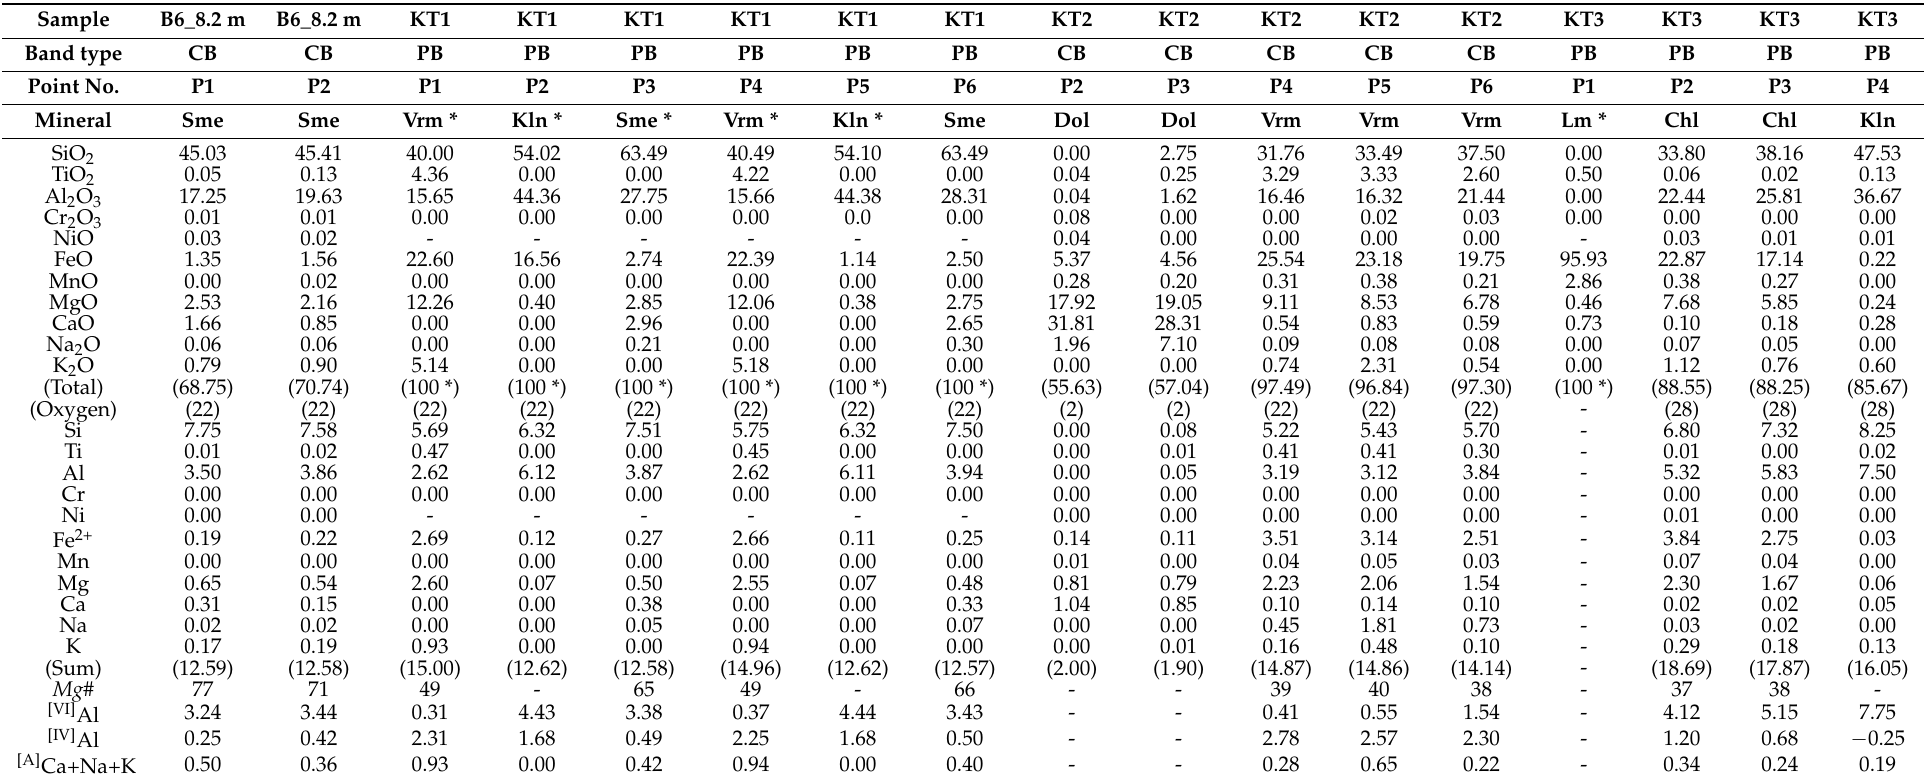
Table 3. Chemical compositions of analyzed minerals (wt.%) with EPMA or SEM-EDS. SEM-EDS analyses are indicated by * marks at the right of both mineral name and total, which are normalized to 100 wt.% in total. For EPMA analyses without * marks, the total is the total weight percent of measured oxide, which does